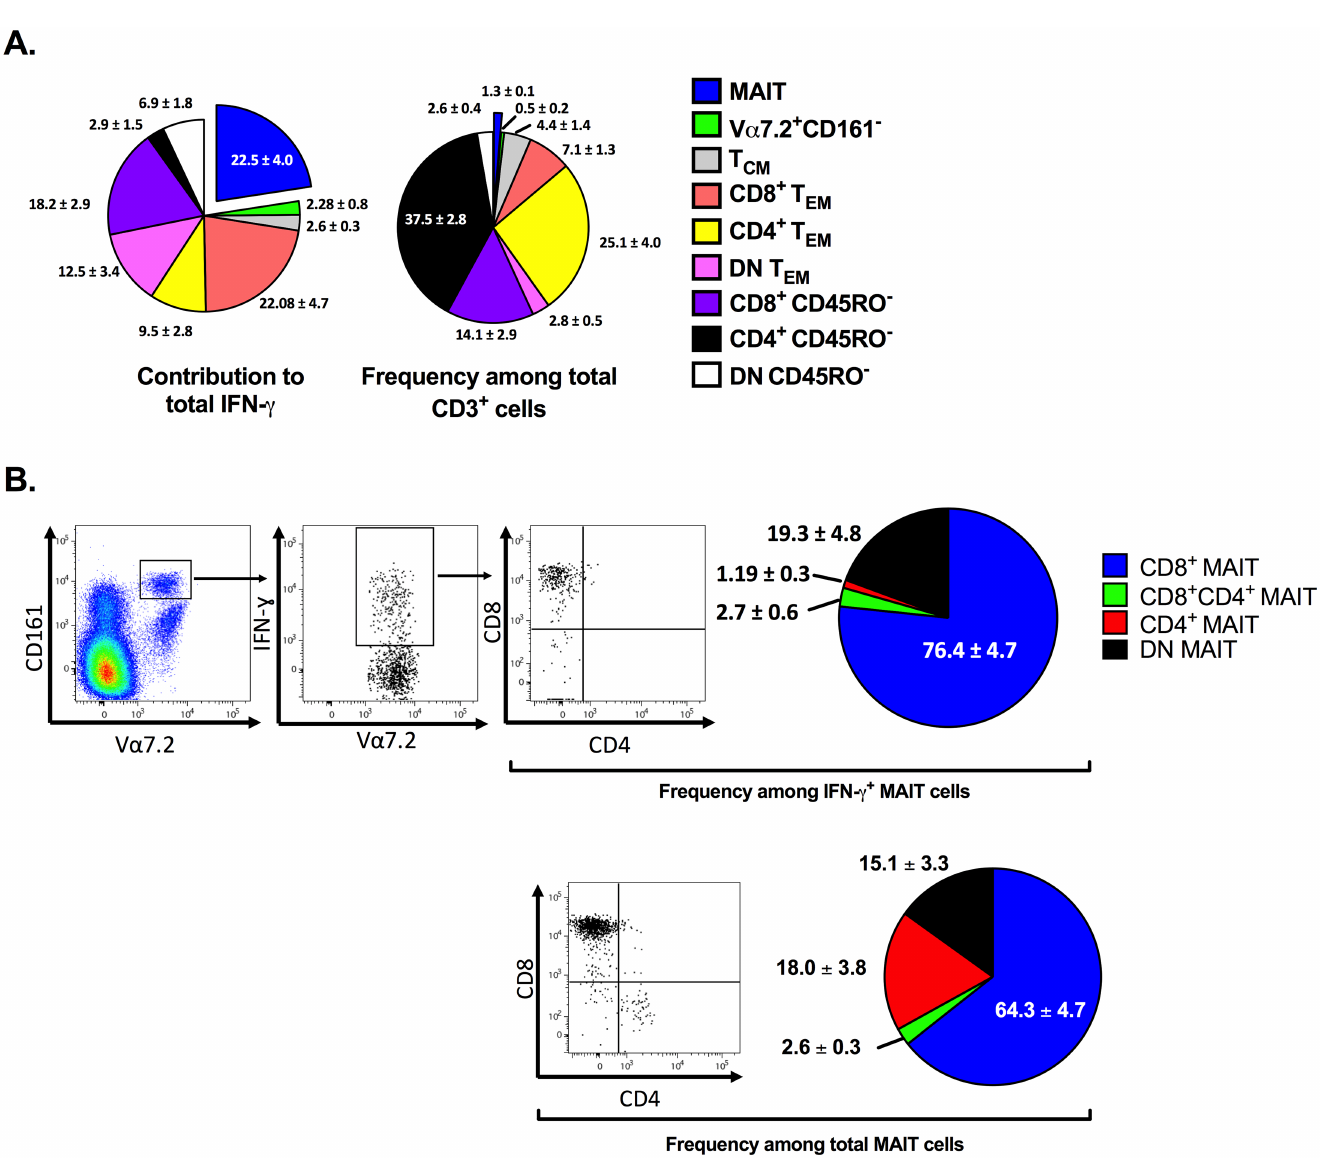
Fig 2. Human CD8 + mucosa-associated invariant T (MAIT) cells mount a more intense interferon (IFN)- γ response to staphylococcal enterotoxin B (SEB) than do memory conventional T (T conv ) cells at the individual cell level. Human peripheral blood mononuclear cells (PBMCs) ( n = 7) were exposedto SEB for 24 h. IFN- γ -producing T cells were then immunophenotypedby flow cytometry to determinethe percentagesof V α 7.2 + CD161 high (MAIT) cells, V α 7.2 + CD161 - cells, CD45RO + CCR7 + V α 7.2 - central memory T (T CM ) cells, the CD4 + , CD8 + , or doublenegative(DN) subsets of CD45RO + CCR7 - V α 7.2 - effector memory T (T EM ) cells, and the CD4 + , CD8 + , or DN subsets of CD45RO - cells ( A ). The frequencies of bulk and IFN- γ + MAIT cells expressingCD4 and/or CD8 were also calculatedand presented in a pie chart ( n = 8) ( B ). The underlyingdata for this figure can be found in S1 Data, and our gatingstrategies are provided in S2